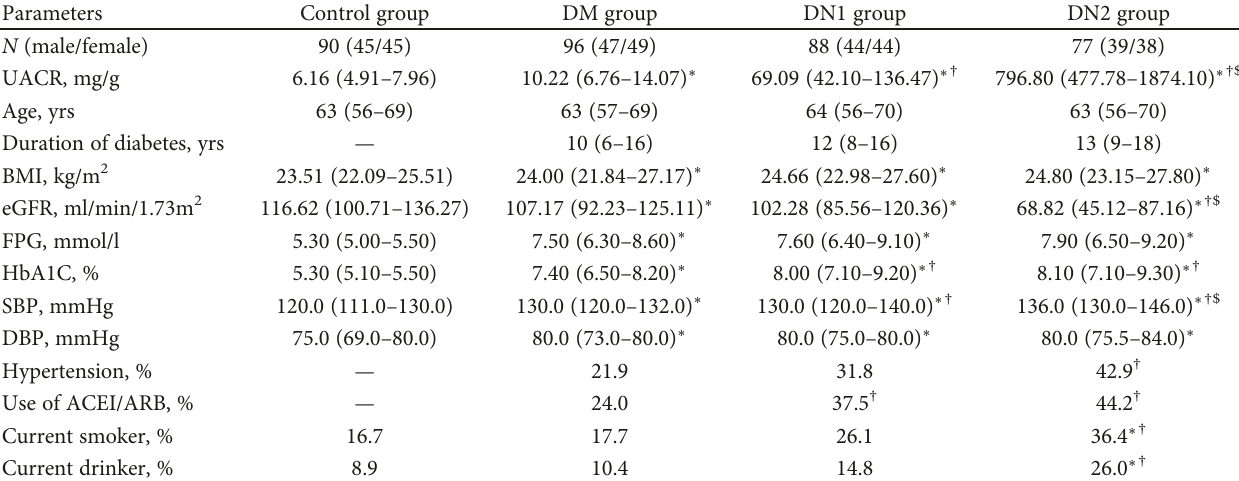
Table 1: General characteristics of subjects included in the analysis.